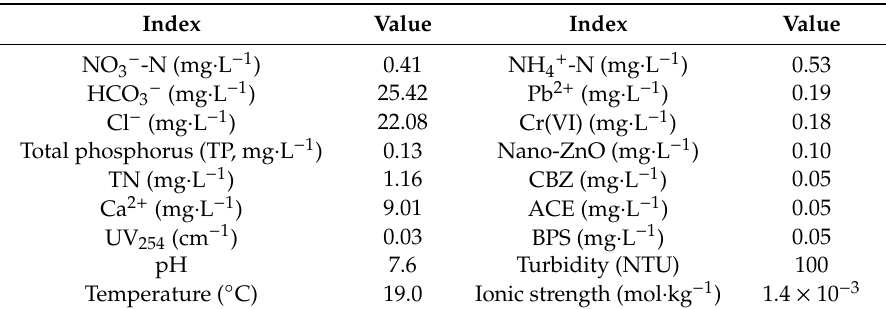
Table 1. Characteristics of the simulated